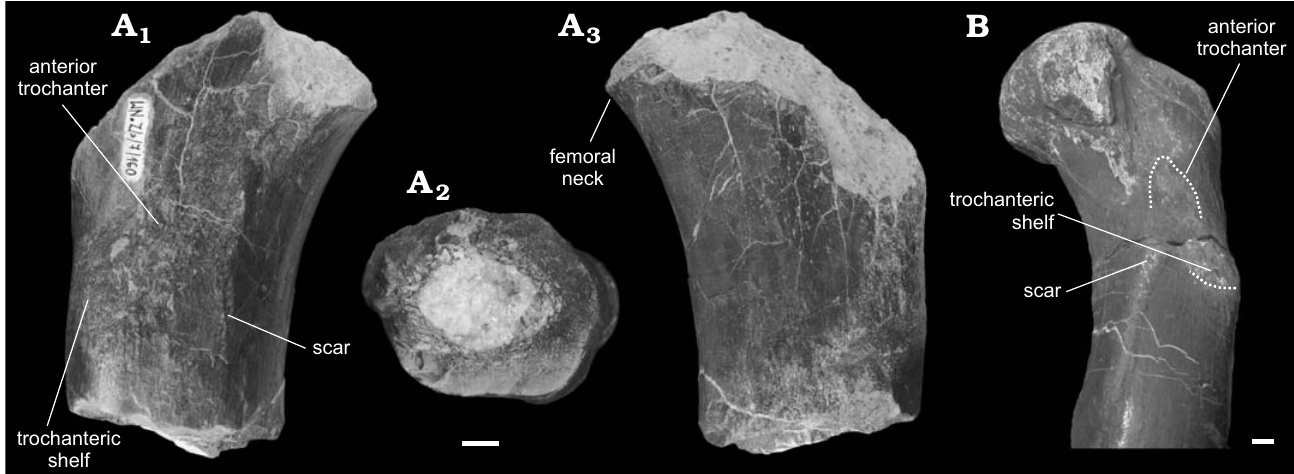
Fig. 3. Predatory archosaurs from Late Triassic of Poland, Smok sp., Marciszów near Zawiercie (A) and Smok wawelski Nied ź wiedzki, Sulej, and Dzik, 2012, Lipie Ś l ą skie clay-pit at Lisowice (B). A . Fragment of proximal region of the right femur (WNoZ/S/7/160), in anterior (A 1 ) and posterior (A 2 ) views, distal cross section (A 3 ). B . Left femur (ZPAL V.33/45) in anteromedial view. Scale bars 10